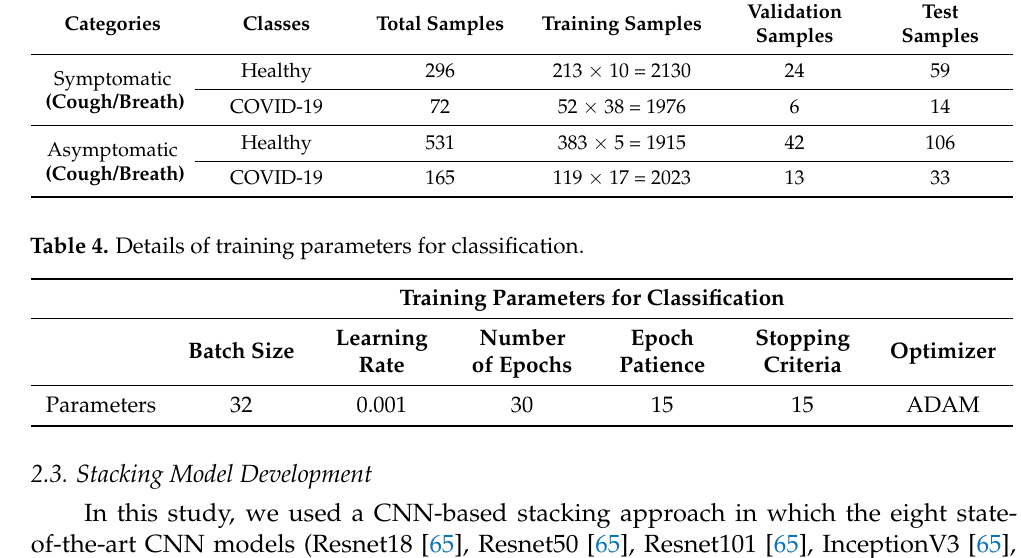
9 of 20 Table 3. Number of mages per class and per fold used for different pipelines. Categories